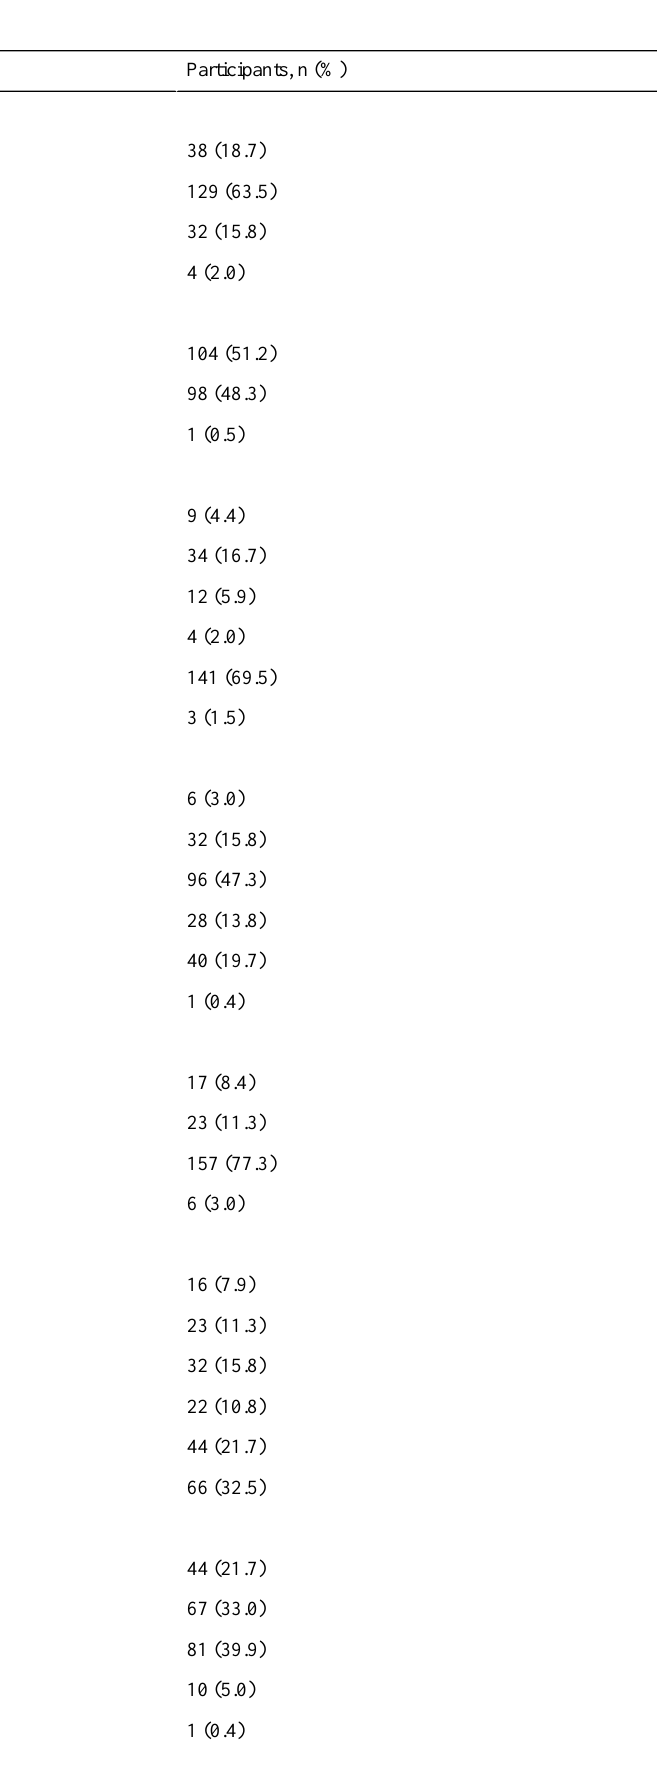
Table 1. Characteristics of survey participants